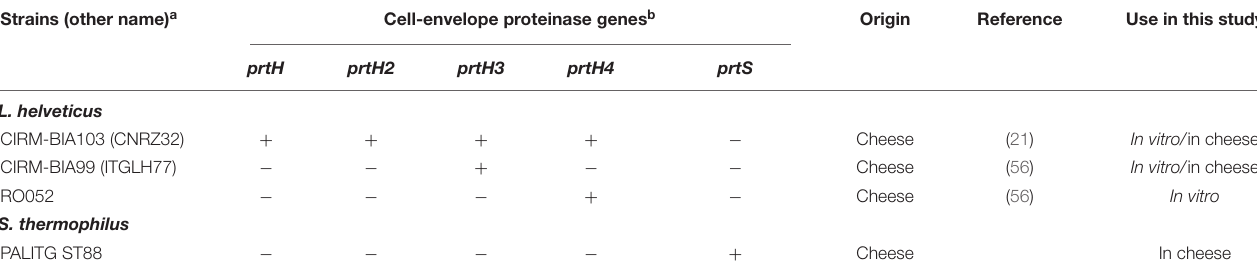
TABLE 1 | Lactobacillus helveticus and Streptococcus thermophilus strains used in this study and CEP genes identified in their genome